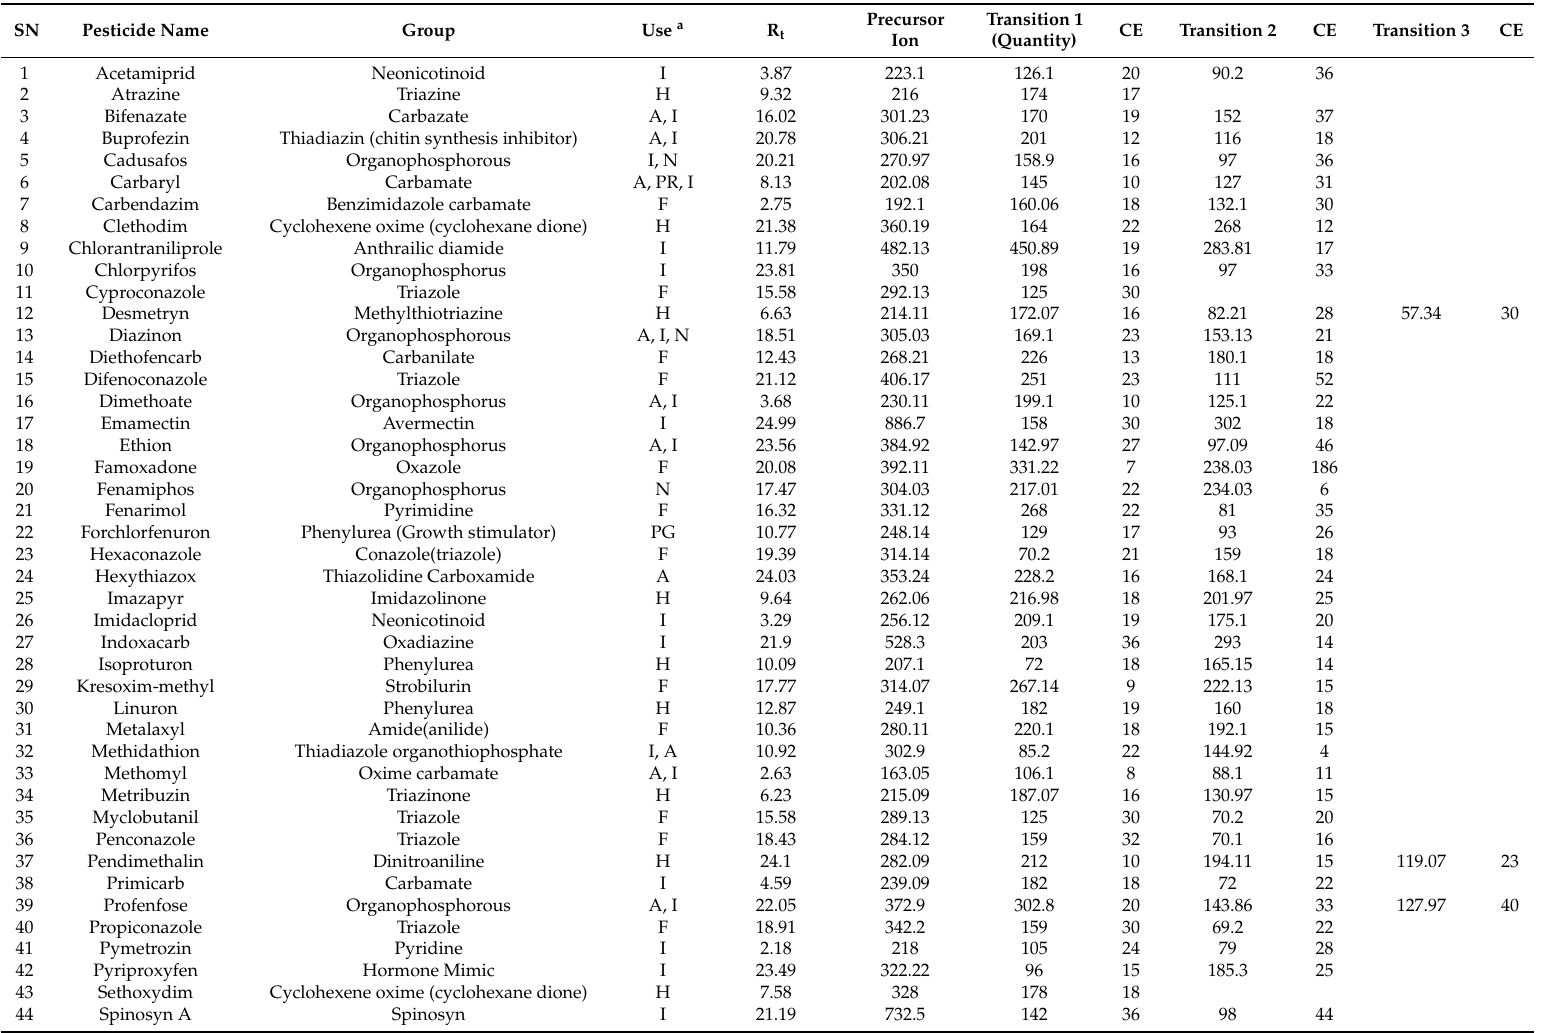
Table 6. Summary of LC-MS / MS pesticides (properties and